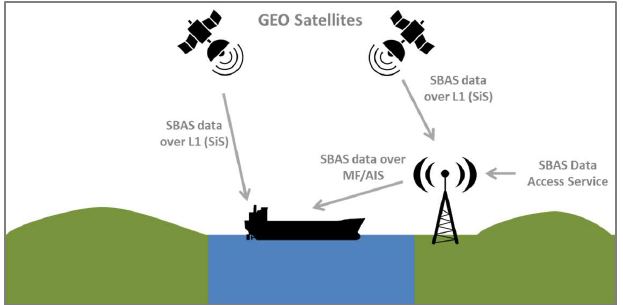
Figure 3. SBAS corrections transmission alternatives.